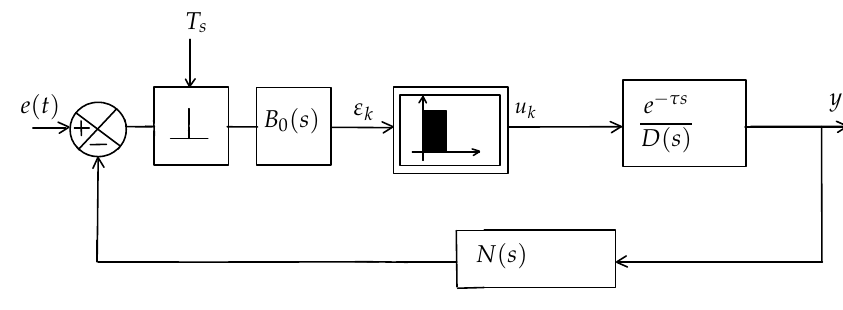
Figure 5. Block representation of the studied system